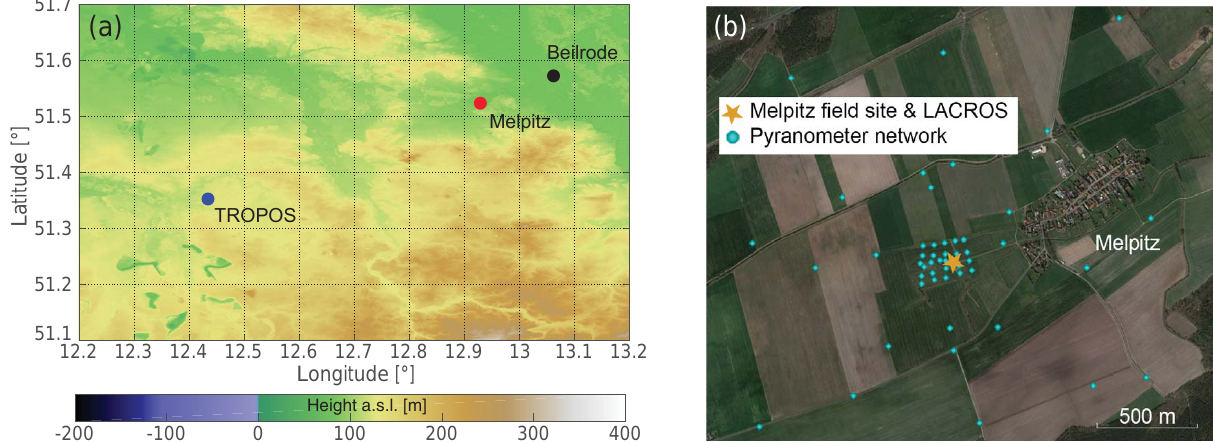
Figure 4. Topography around the location of the HOPE-Melpitz campaign. (a) Large-scale topography; (b) aerial photograph of the Melpitz field site with the locations of the pyranometers of the